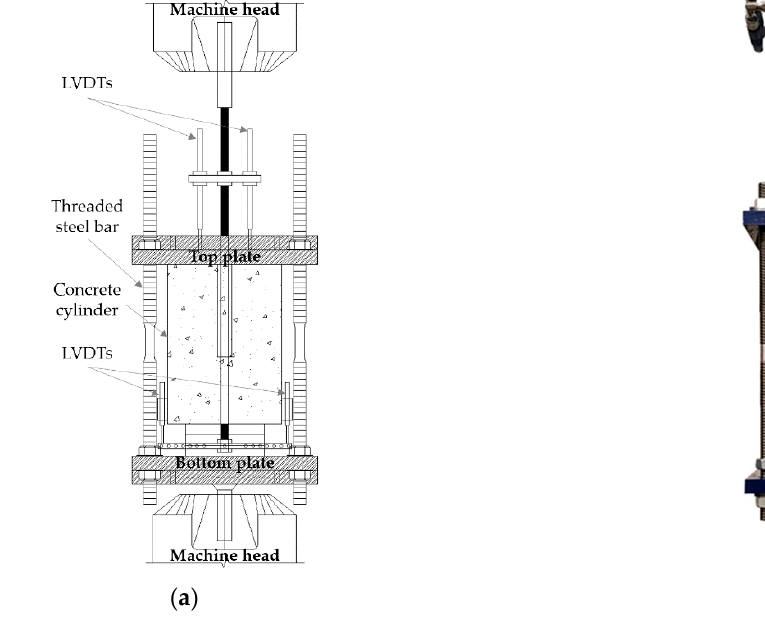
Figure 16. ( a ) Schematic of the pull-out test set-up; ( b ) Photo of the test [5]. Threaded hollow cylinders were glued at the top end of the bar to improve the gripping of the GFRP bar by the semi-moon jaws of the servo-hydraulic machine. The concrete cylinder reacted against a 25 mm thick steel plate on the top named the top plate . The top plate had a hole at the center to pass the GFRP bar through, and it was connected to another plate on the bottom of the cylinder called the bottom plate . The top plate was connected with the bottom plate by 22 mm diameter threaded steel bars featuring frictionless bearings to reduce torsion. This bottom plate was connected to the jaws of the servo-hydraulic machine by means of a square steel plate and a stud. Three LVDTs were attached to the top part of the GFRP bar (120 ◦ apart) at a distance of 130 mm from the top surface of the concrete cylinder. The average of these three LVDTs was used to control the test. The slip g for the pull-out tests was computed by subtracting the GFRP bar deformation (between the LVDTs and the beginning of the bonded area) from the average of the LVDT readings. The bonded length of the pull-out tests was 240 mm. The bonded length on each side of the notch in the beams was 225 mm. Even though the bonded length in the pull-out test was slightly larger than the bonded length of the GFRP bar in each half of the notched beams, the comparison of the pull-out test responses with the P bar versus g plots shows that the responses are in good agreement with each other. Interestingly, the P bar versus g response of specimen PN_B_2 indicates that the load in the notched beam increases at a different rate with respect to g when compared to the force in the bar in pull-out tests, which suggests that the pull-out tests could be considered an upper bound in terms of the bond behavior of GFRP bars in structural elements. The reason behind this observation could be the effect of bending that is present in the TPB tests of notched beams, which could imply a non-uniform distribution of the interfacial shear stresses along the perime- ter of the bar. 6.5. Contour Plots from Digital Image Analysis The contour plots of the horizontal strain component ( ε xx ) are shown in Figure 17a– d. The reference system for these plots is the Cartesian coordinate system shown in Figure 3d. The area of interest for the contour plots is a rectangle of 50 mm width and 150 mm height centered at the tip of the notch. The choice of the area of interest was to investigate the width of the FPZ at different load points. For the PN_B_X series, three contour plots are shown corresponding to three points of the load response. These points correspond to